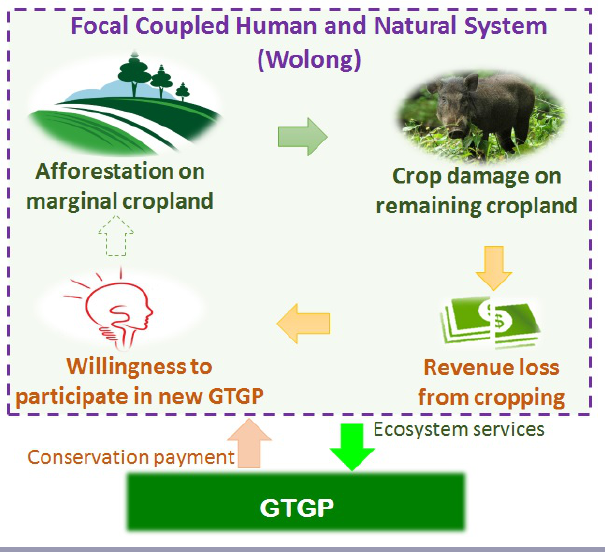
Fig. 1 . Conceptual model of the feedback effect of the Grain to Green Program (GTGP) in Wolong. Through GTGP, other distant places (as represented by the Chinese government in Beijing) paid local farmers for converting their marginal cropland to forestland to secure the provision of ecosystem services. However, afforestation on marginal cropland significantly increased crop damage on nearby remaining cropland in Wolong, and reduced the revenue local households obtained from the affected cropland. This in turn increased local households’ willingness to enroll remaining cropland in possible future GTGP and will strengthen the effects of GTGP (e.g., outflows of ecosystem services to other places) in Wolong and beyond if a new round of GTGP is implemented in the